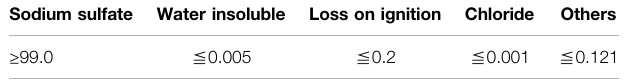
TABLE 2 | Speci fi cation parameters of sodium sulfate. Sodium sulfate Water insoluble Loss on ignition Chloride